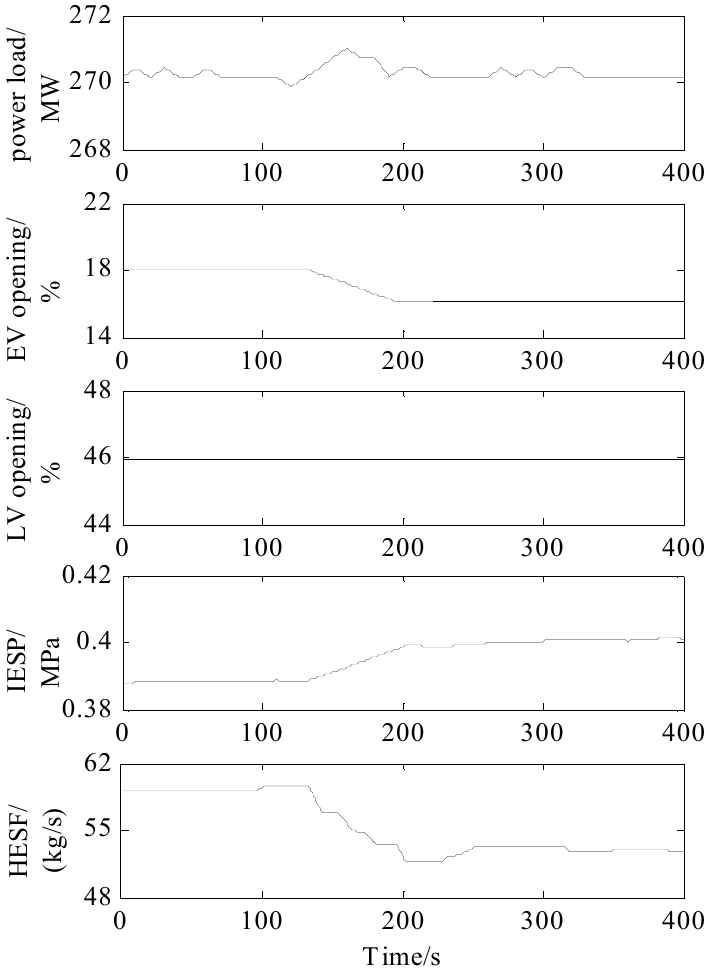
Figure 4. Dynamic response to EV opening.